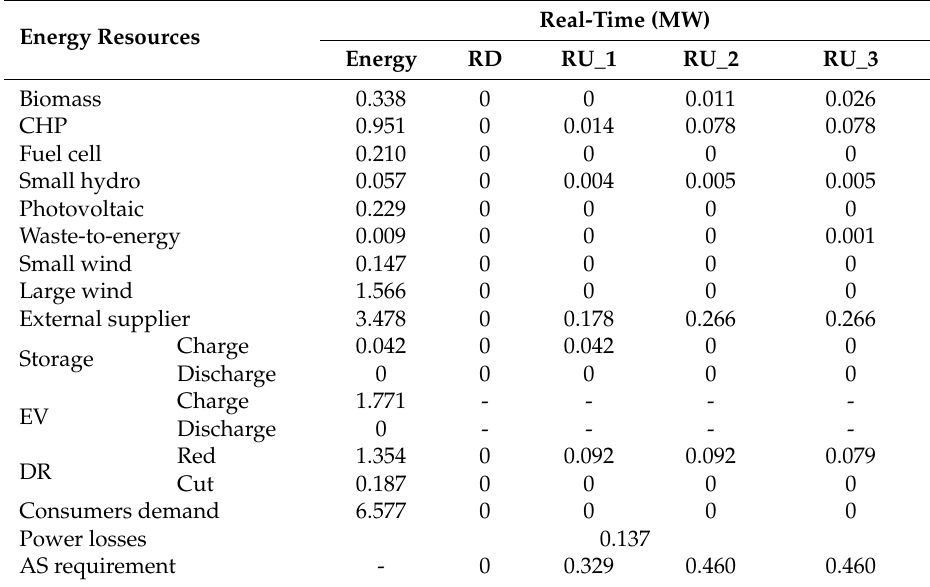
Table 4. Energy and reserve scheduling on hour 10 in real-time